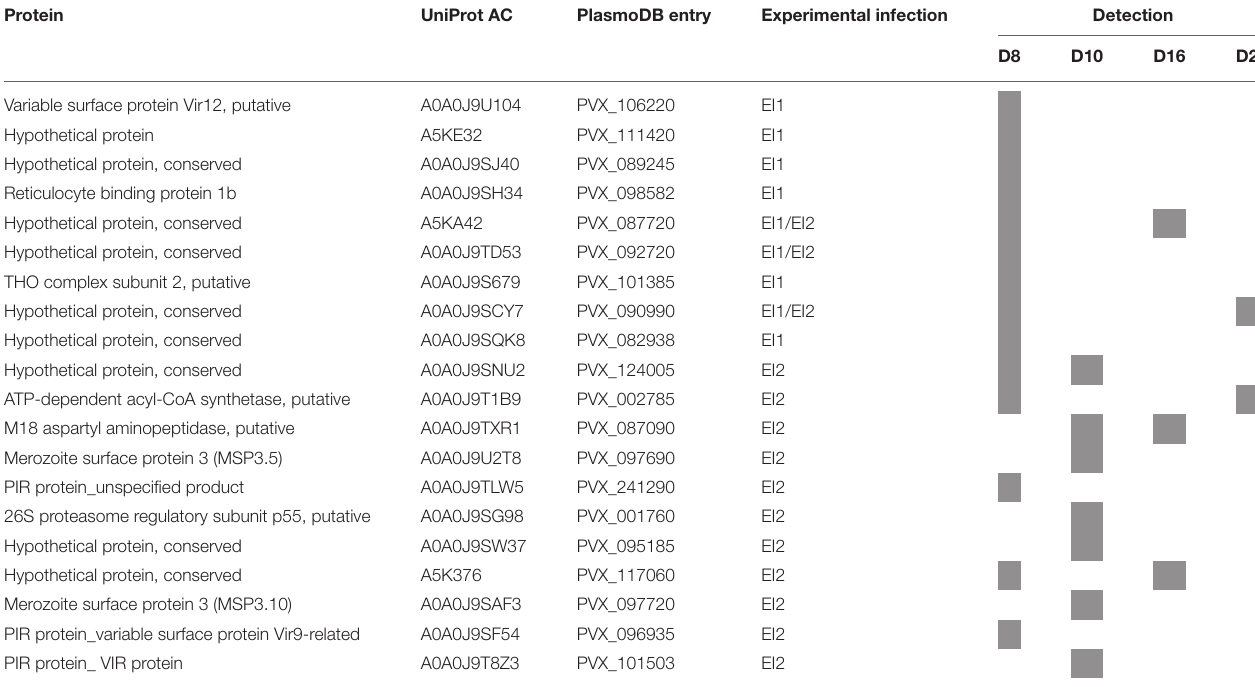
TABLE 2 | Plasmodium vivax proteins identified in the microvesicles-enriched SEC fractions (MvEF) of plasma-derived exosomes from FRG huHep infected mice.